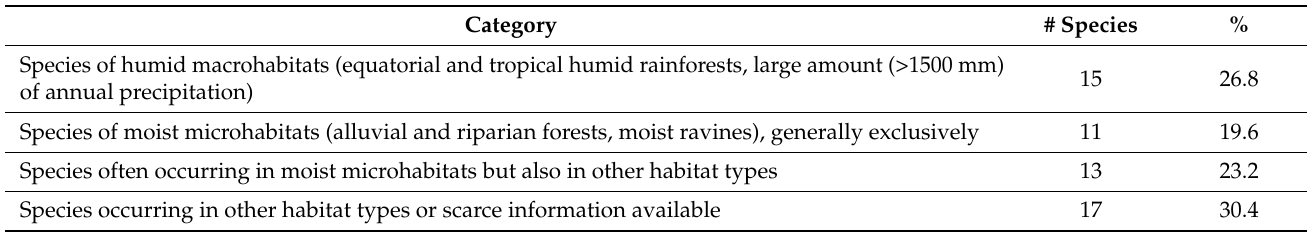
Table 2. Division of Ulmaceae according to their macro- and microhabitats, with a focus on humid habitats. # Species: number of species.